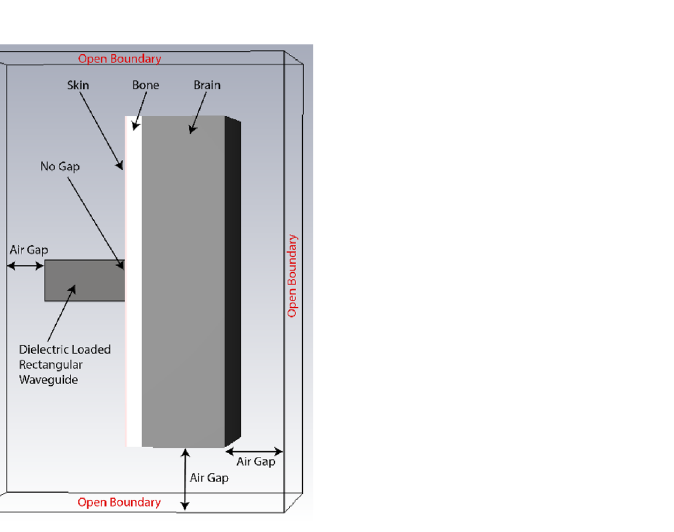
Figure 2. Experimental setup—rectangular waveguide aperture against an inhomogeneous human head phantom.